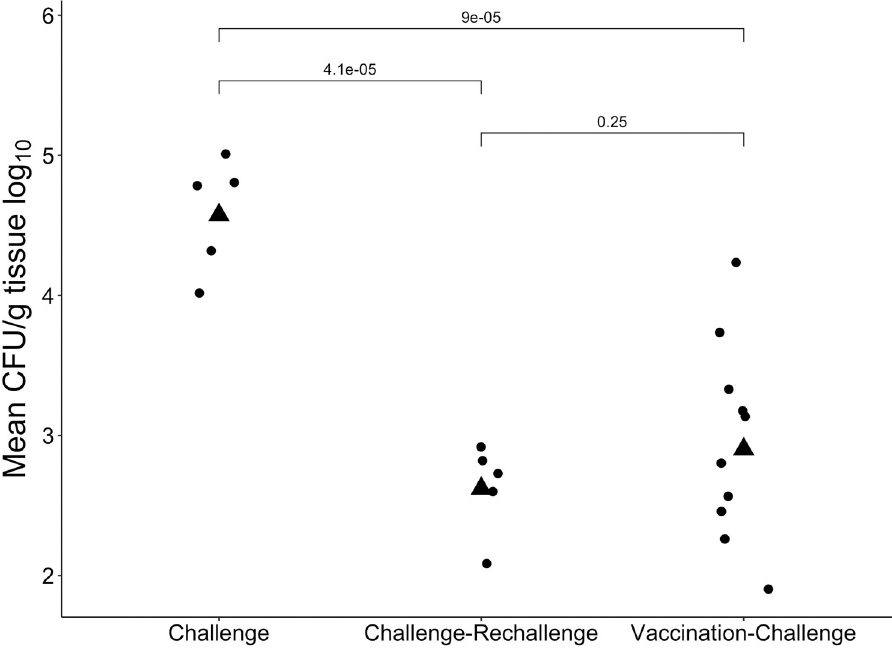
Fig 3. Mean CFU/g of ETEC strain B7A after na ï ve challenge, challenge followed by rechallenge, and vaccination followed by challenge. The challenge and rechallenge dose were 10 11 CFU of strain B7A. Mean CFU/g for each rabbit is plotted as circles, with the geometric mean of the treatment group displayed as a triangle. P values shown are the result of Student’s T-tests comparing mean CFU/g of all rabbits in each treatment group.